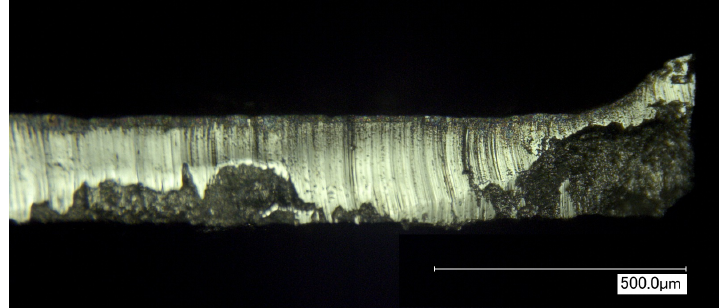
Figure 1. Microscopic photograph of the side view of a punched electrical steel lamination with edge burr on the right hand side. This photo was taken using a Keyence digital microscope with 250 times